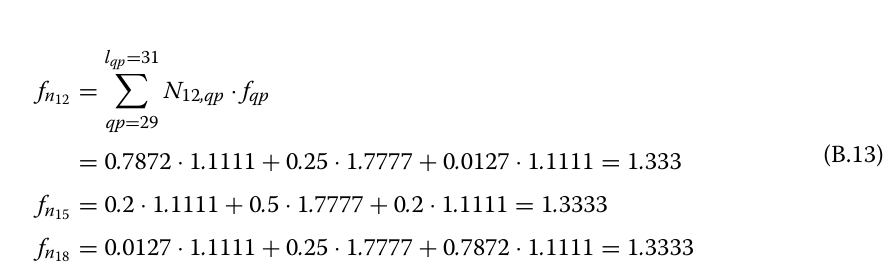
shape functions are taken from Table